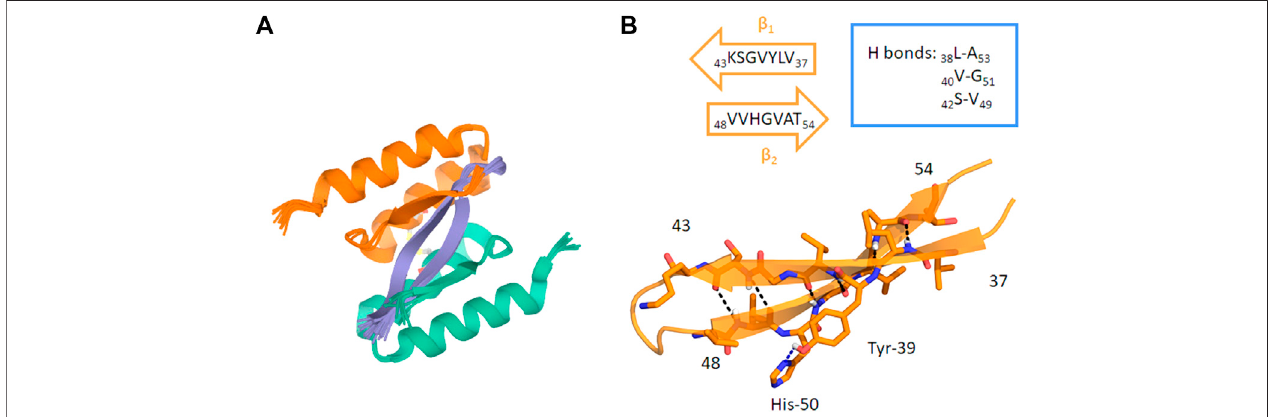
FIGURE 9| (A) Ribbon drawing ofthe AS69 structure interactingwiththe α Syn β -hairpin (residues 36 – 55). In light orange and green, the twosubunits ofAS69 are shown. Each subunit spans residues 13 – 58 of AS69. (B) Ribbon drawing of the α Syn β -hairpin (orange, β 1 and β 2 strands). H-bonds are depicted by dashed lines. The main interacting residues are shown as sticks (Mirecka et al., 2014).